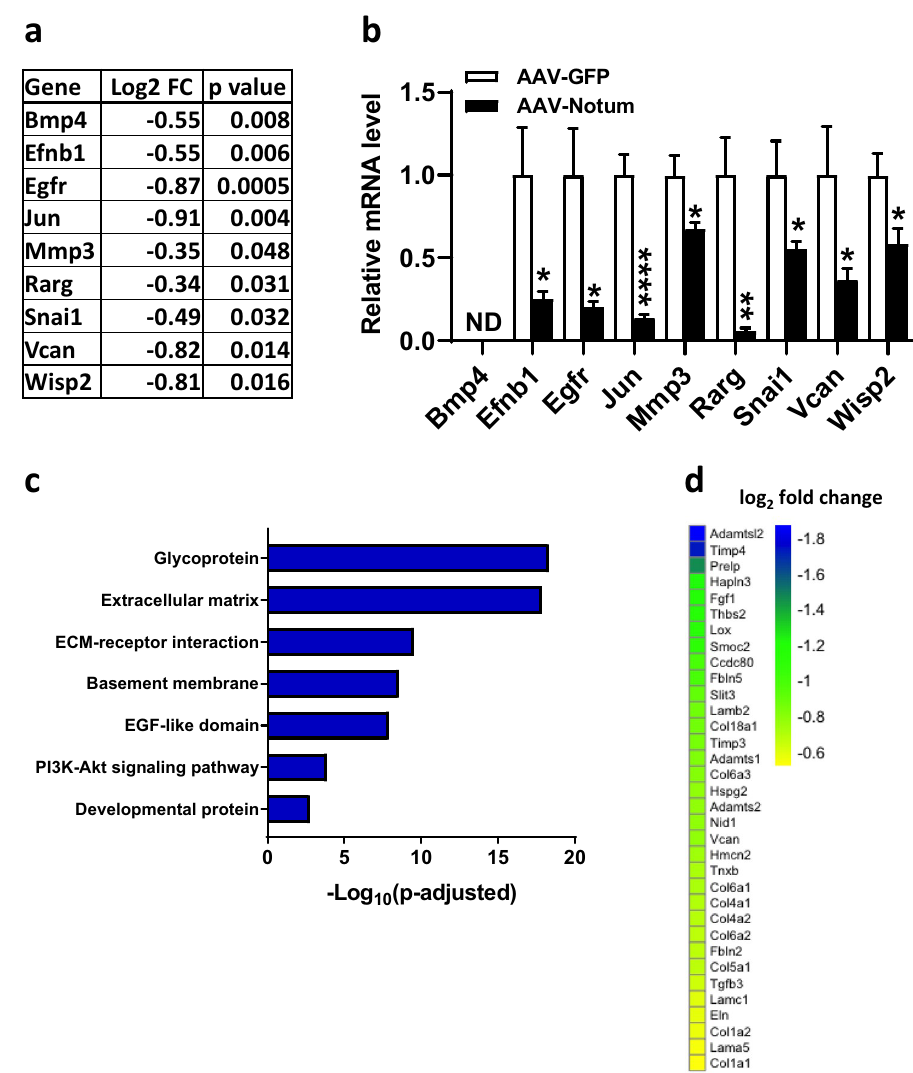
Figure 7. NOTUM overexpression leads to substantial changes in global gene expression in iWAT of chow diet- fed mice. RNA-seq analysis were performed on iWAT samples collected from the same chow diet fed mice as described in Fig. 6. ( a ) Wnt target genes that were differentially expressed between the AAV-Notum and AAV- GFP groups were shown. ( b ) qPCR data of the same Wnt target genes described in ( a ) are shown. ( c ) Repressed functional clusters in the iWAT of AAV-Notum treated mice compared to the AAV-GFP treated mice are shown. ( d ) Heat map of log 2 fold changes of ECM cluster transcripts in the iWAT of AAV-Notum treated mice compared to those of the AAV-GFP treated mice are shown. Symbols: *: p < 0.05, **: p < 0.01, ****: p < 0.0001, AAV-GFP versus AAV-Notum, as determined by Student’s t-test. ECM Extracellular matrix, EGF Epidermal growth factor, FC Fold change, ND Not